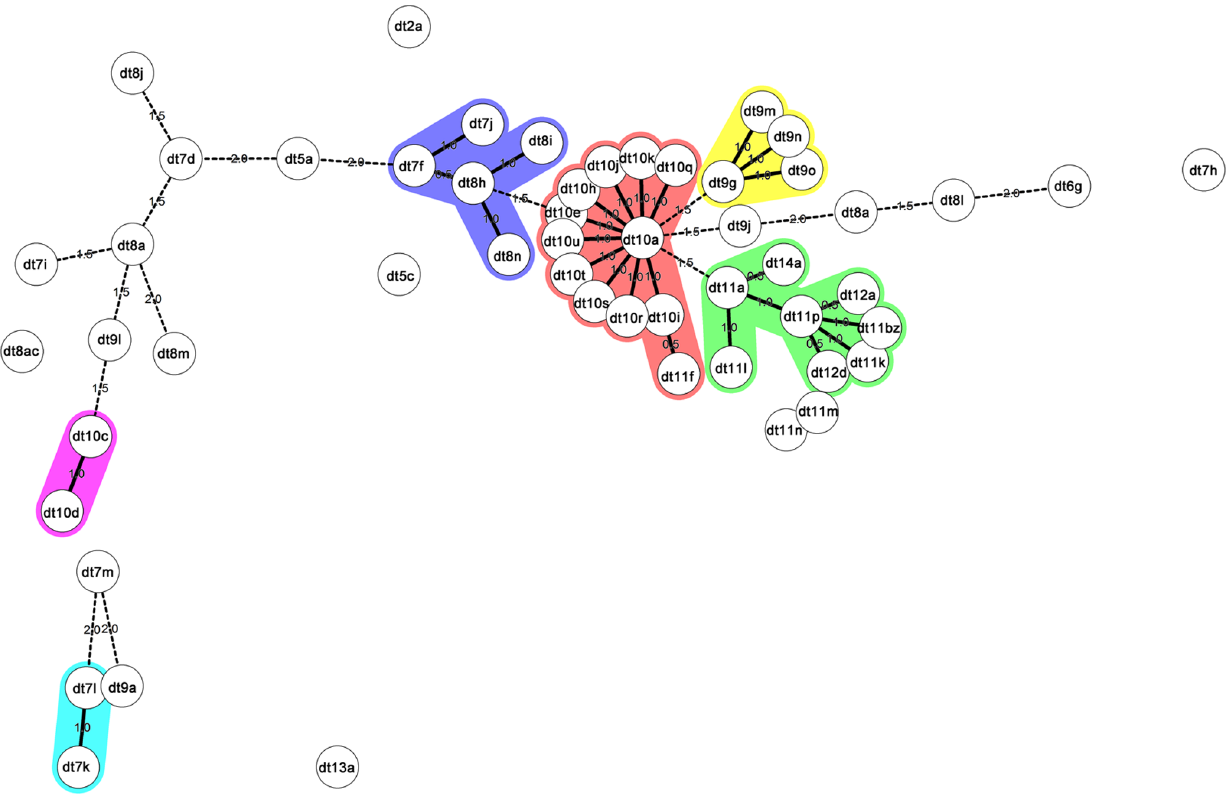
Figure 1. Minimum Spanning Tree generated using the BioNumerics software program representing the 53 dru types observed in the study isolates. Numerical values on the branches indicate the similarity (MST distance) between different dru types. BioNumerics software creates similarity values (termed bins) and converts these data into distance units. The bin unit distance was set to 0.5% (i.e., dru types at a distance of 1 on the MST have between 99 and 99.5% similarity, types at a distance of 2 have between 98.5 and 99% similarity, etc.). The dru types were assigned to the same (colored) cluster if they were separated by an MST distance of , 2 (i.e., if they showed . 98.5% similarity).